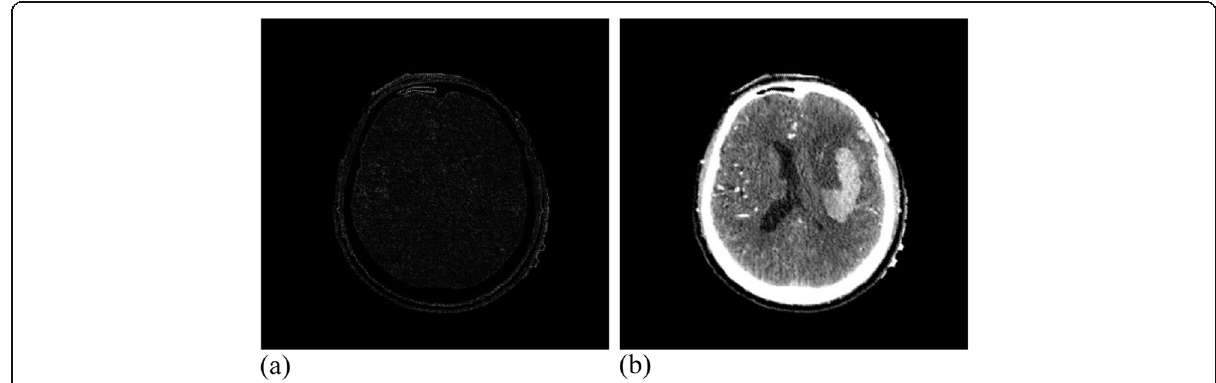
Fig. 11 CT data after registration. ( a ): Difference between CT reference image and registration image; ( b ): CT registration image